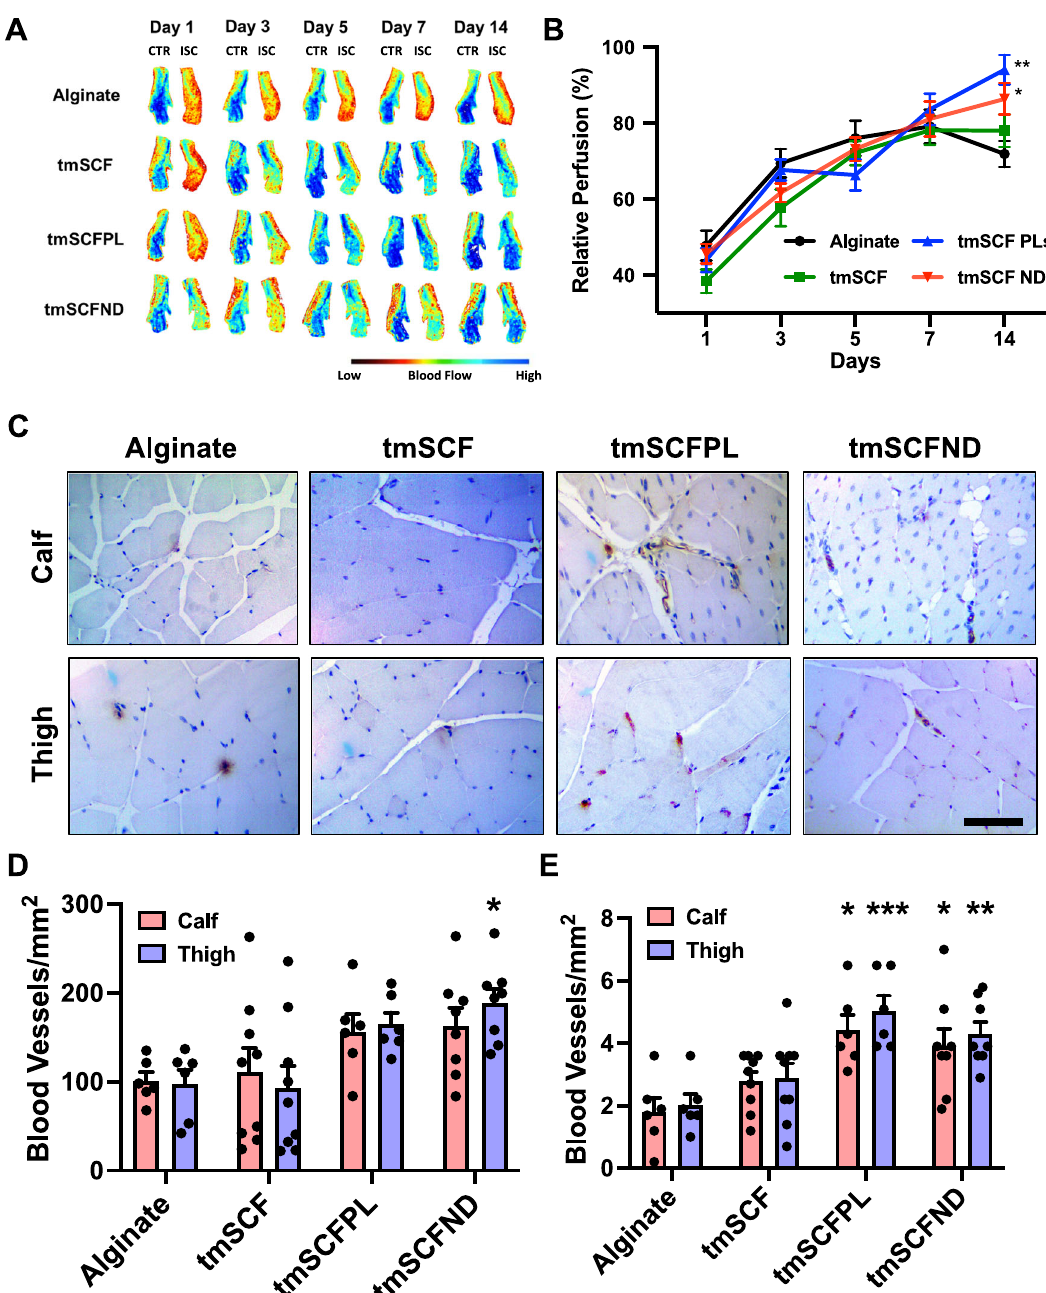
Fig. 3 Evaluation of treatments in a hindlimb ischemia model on wild type mice. A Representative mice foot images taken by laser speckle imaging. B Relative blood fl ow recovery after hind limb ischemia surgery on WT mice ( n = 13 for tmSCFND, 12 for other groups). p = 0.006 (tmSCFPL vs control) and p = 0.037 (tmSCFND vs control) * indicates p value < 0.05 ** p < 0.01. C Immunostaining for PECAM on mice on the muscles from the ischemic calf and thigh muscle of the mice after 14 days. Scale bar = 100 µ m. D Quanti fi cation small blood vessels in the calf and thigh muscle counted from PECAM immunostaining images ( n = 7 for tmSCF, 4 for other groups). * p = 0.0116 on tmSCFND vs alginate. E The number of large blood vessels in the tissues ( n = 7 for tmSCF, 4 for other groups). p = 0.043 on tmSCFPL vs control and p = 0.0295 on tmSCND vs control on calf muscle. p = 0.0005 on tmSCFPL vs control and p = 0.0038 on tmSCFND vs control on thigh muscle. Two-sided one-way ANOVA with Dunnett ’ s post hoc test was used. * indicates p value < 0.05, ** < 0.01, and *** <0.001. All the error bars are